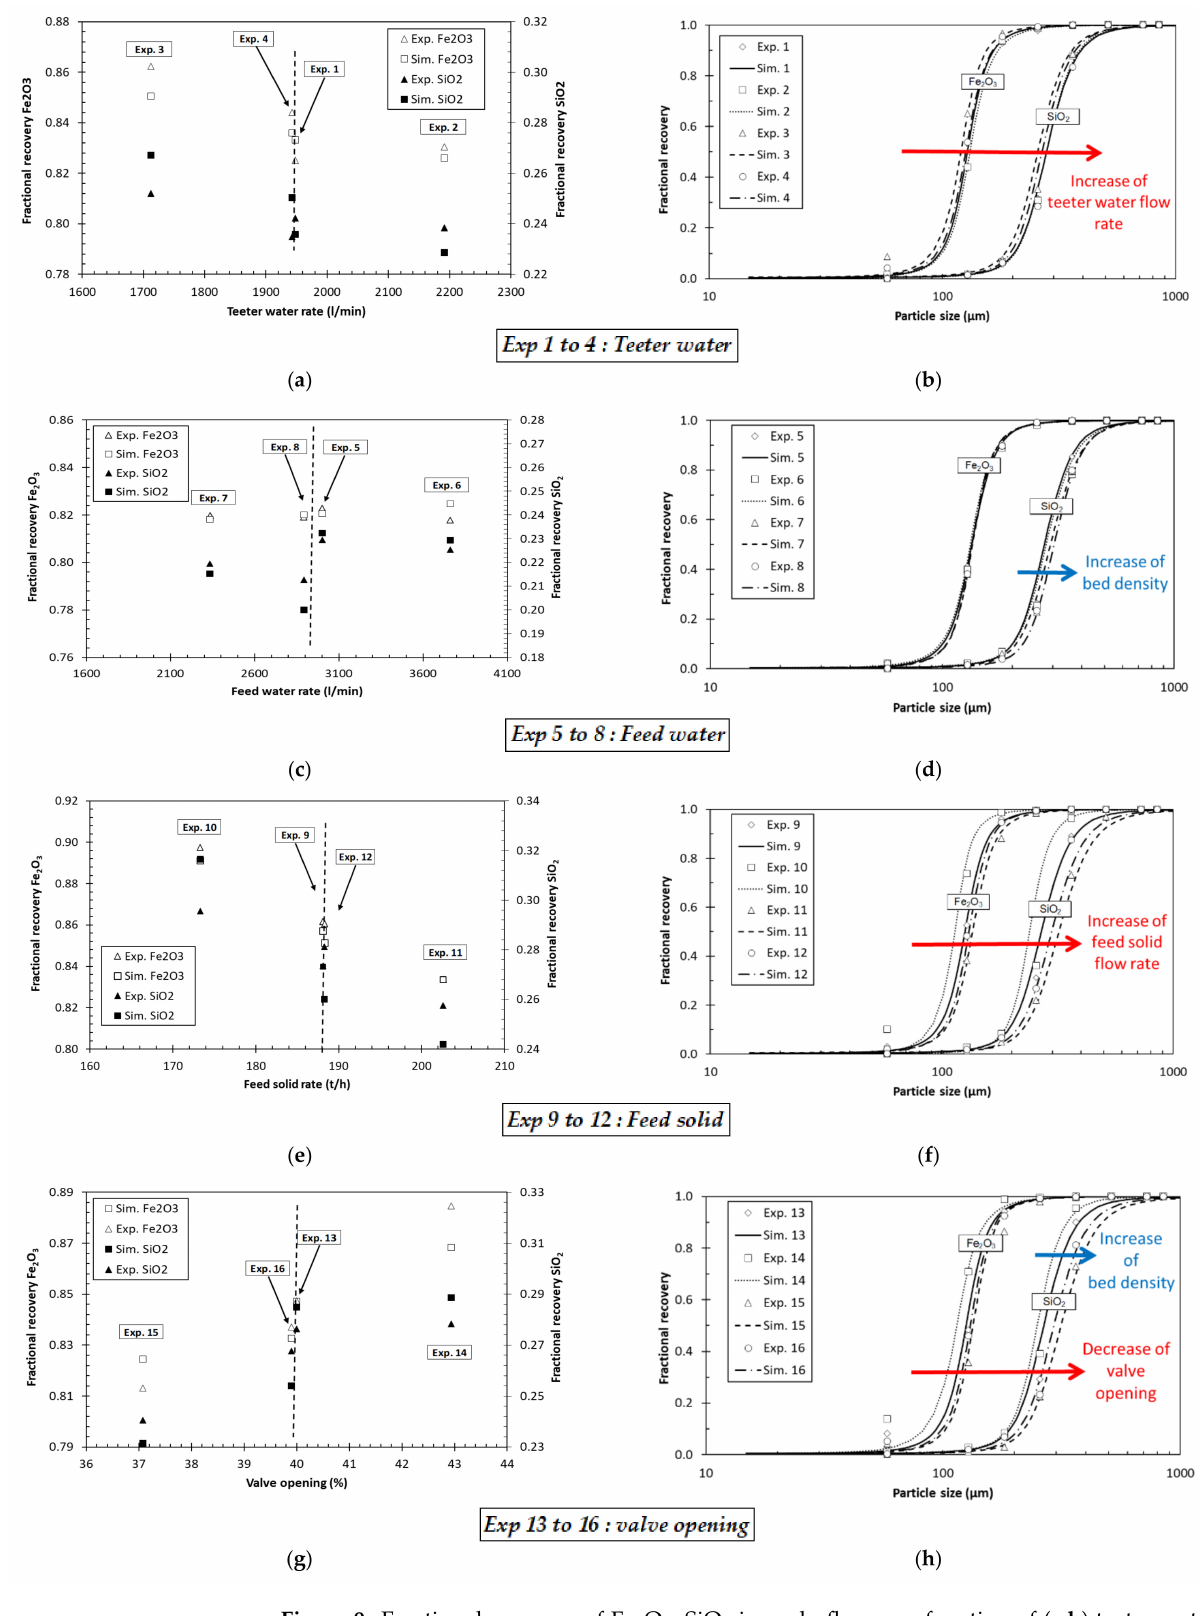
Figure 9. Fractional recovery of Fe 2 O 3 , SiO 2 in underflow as a function of ( a , b ) teeter water rate (exp. 1–4), ( c , d ) feed water rate (exp. 5–8), ( e , f ) feed solid rate (exp. 9–12) and ( g , h ) valve opening (exp. 13–16); exp: